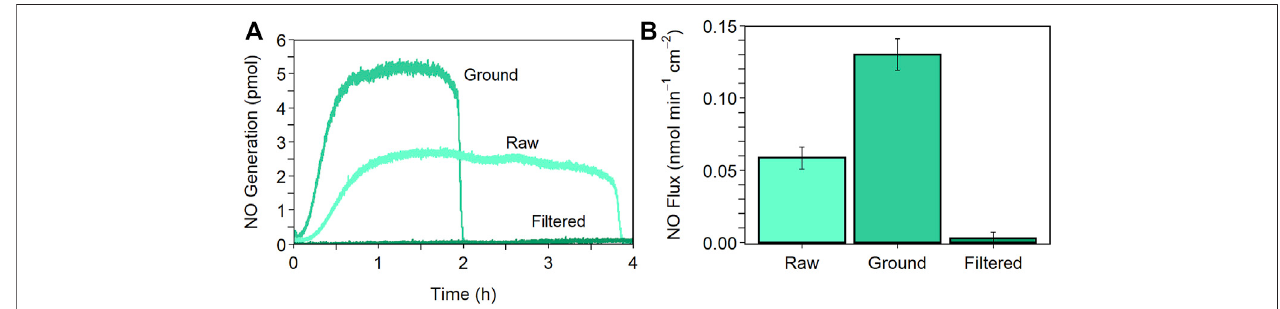
FIGURE 1 | NO generation as a function of MOF particle preparation. (A) Representative NO release pro fi les and (B) average NO fl ux comparing the raw, ground, and fi ltered MOF particles. Experiments conducted using the NOA in ultrapure water with constant N 2 bubbling at 25 ° C shielded from light with 10 × 10 – 6 M GSNO. Composites (1.2 cm diameter) comprised of 5 wt.% MOF and 3 w/v% PU. Data reported as mean ± SD ( n =